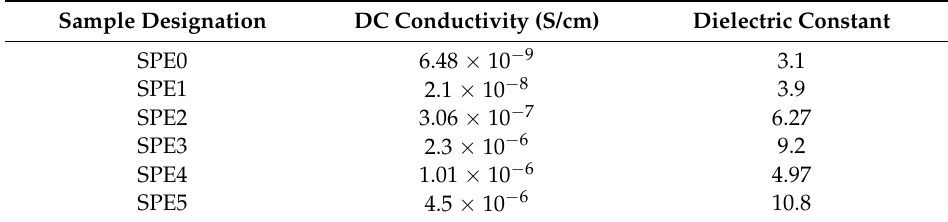
Table 2. DC ionic conductivity and ε (cid:48) of pure PVA and PVA:AgNt complexes at ambient